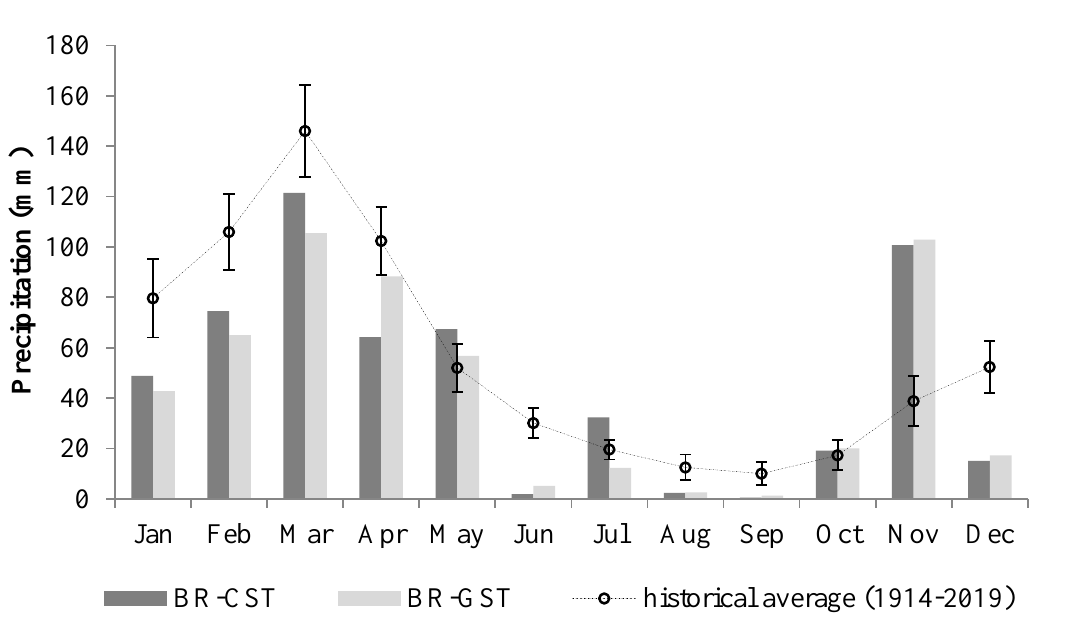
Figure 4. Distribution of total monthly precipitation in the BR-CST and BR-GST towers and historical monthly averages (1914–2019).